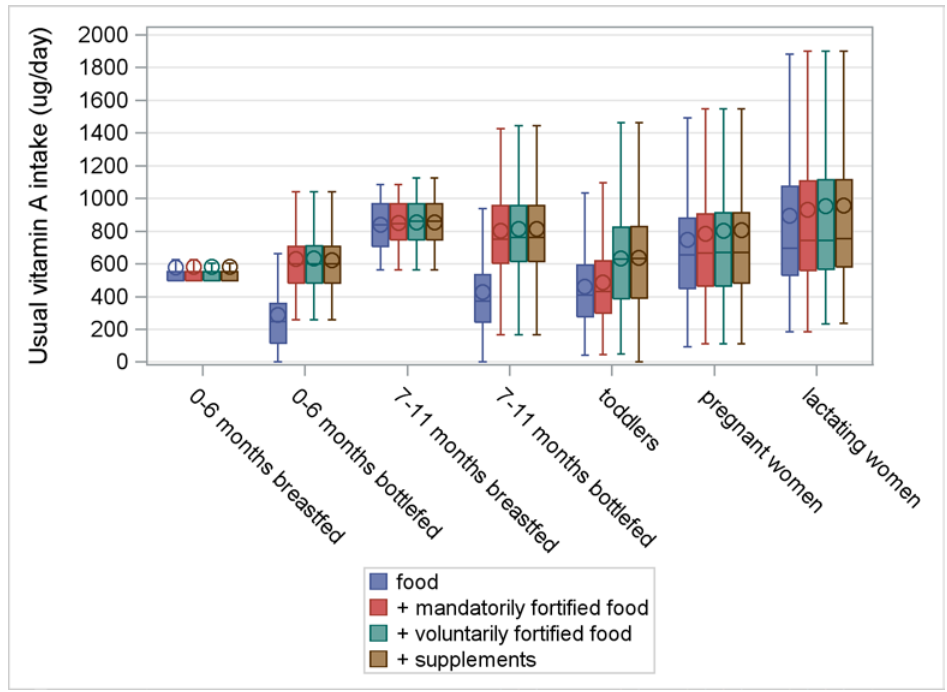
Figure 1. Usual intake of vitamin A (μg/day) from food, fortified food, and supplements in infants, toddlers, pregnant women, and lactating women from a Belgian study on the intake of vitamins A, D, E, and K (VITADEK-study) 2015.